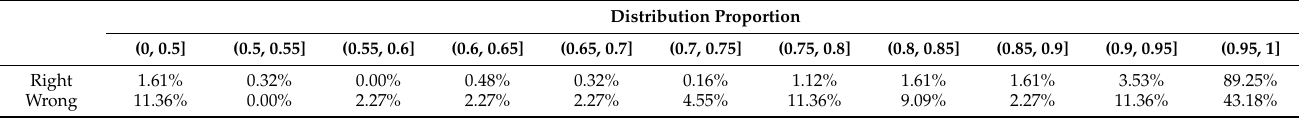
Table 4. p ’s distribution of samples detected by RGBI model. “Right” represents correctly detected samples, “Wrong” represents incorrectly detected samples.